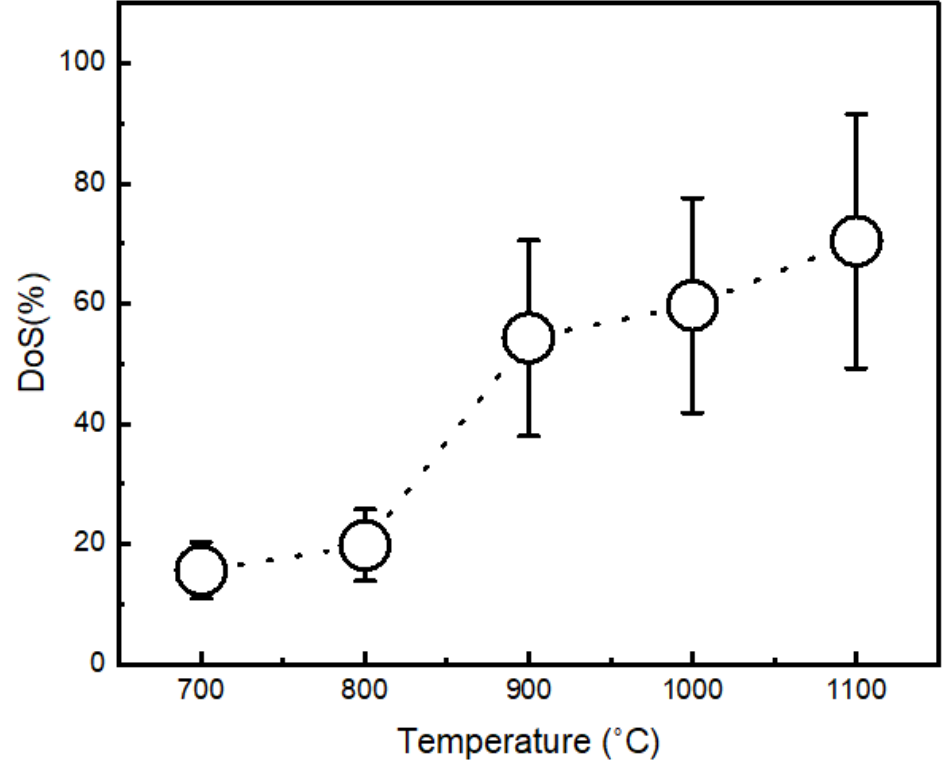
Figure 11. The degree of spallation (DoS) of the samples. The DoS was measured using spalled and unspalled areas. The time for study is the same, i.e., 8 h.